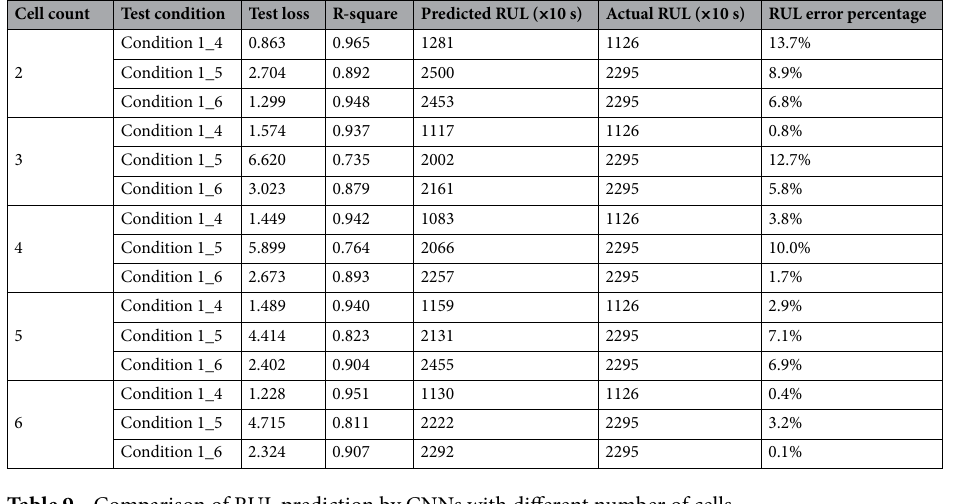
Table 9. Comparison of RUL prediction by CNNs with different number of cells.